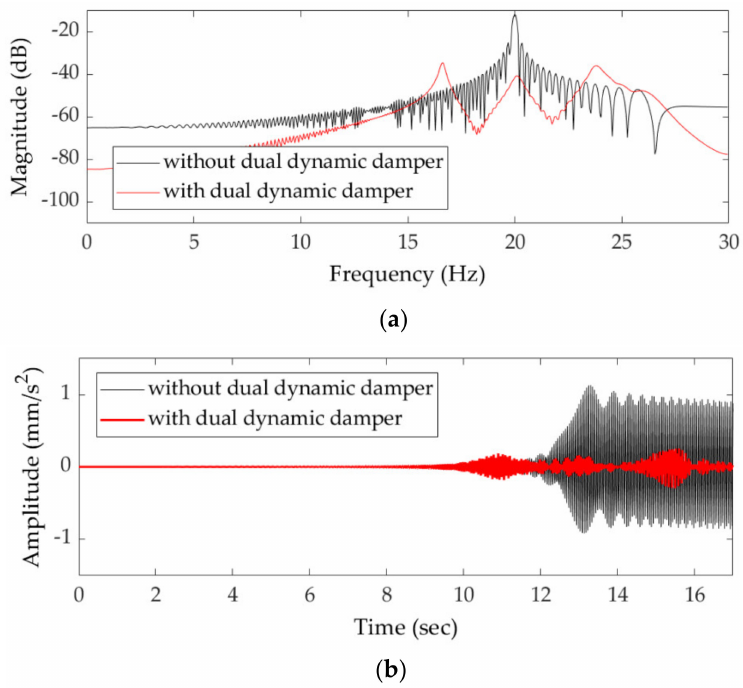
Figure 7. Numerical simulation results of dual dynamic absorber. ( a ) Frequency response, ( b ) Time response